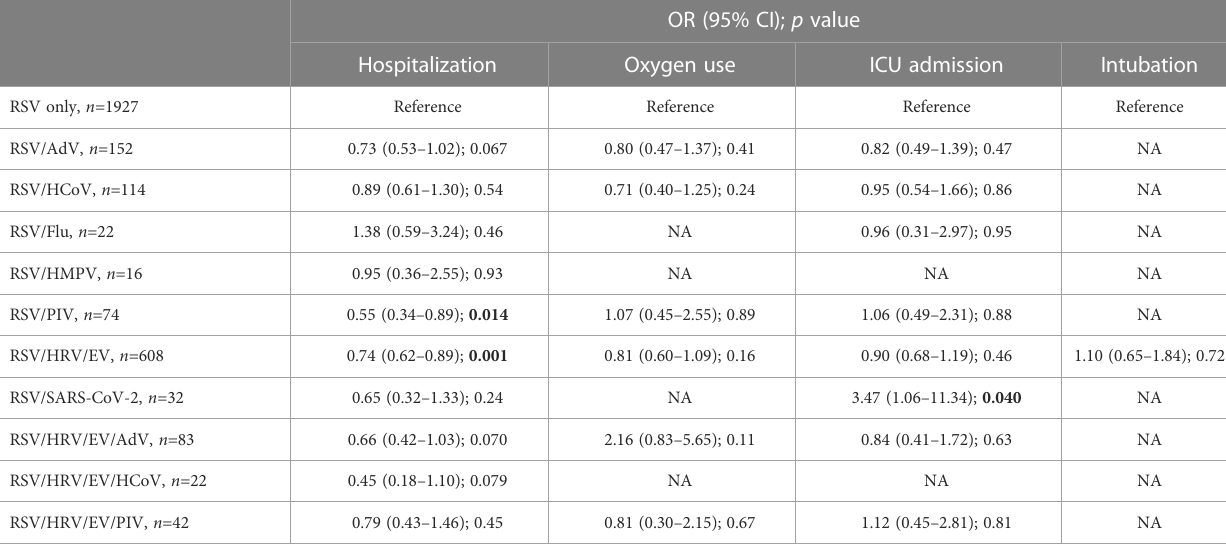
TABLE 3 Logistic regression models comparing the odds of hospitalization, and among those hospitalized, oxygen use, ICU admission, and intubation between children 0 – 4 years old with RSV single detection (reference group) and those with co-detection with speci fi c viral combinations.